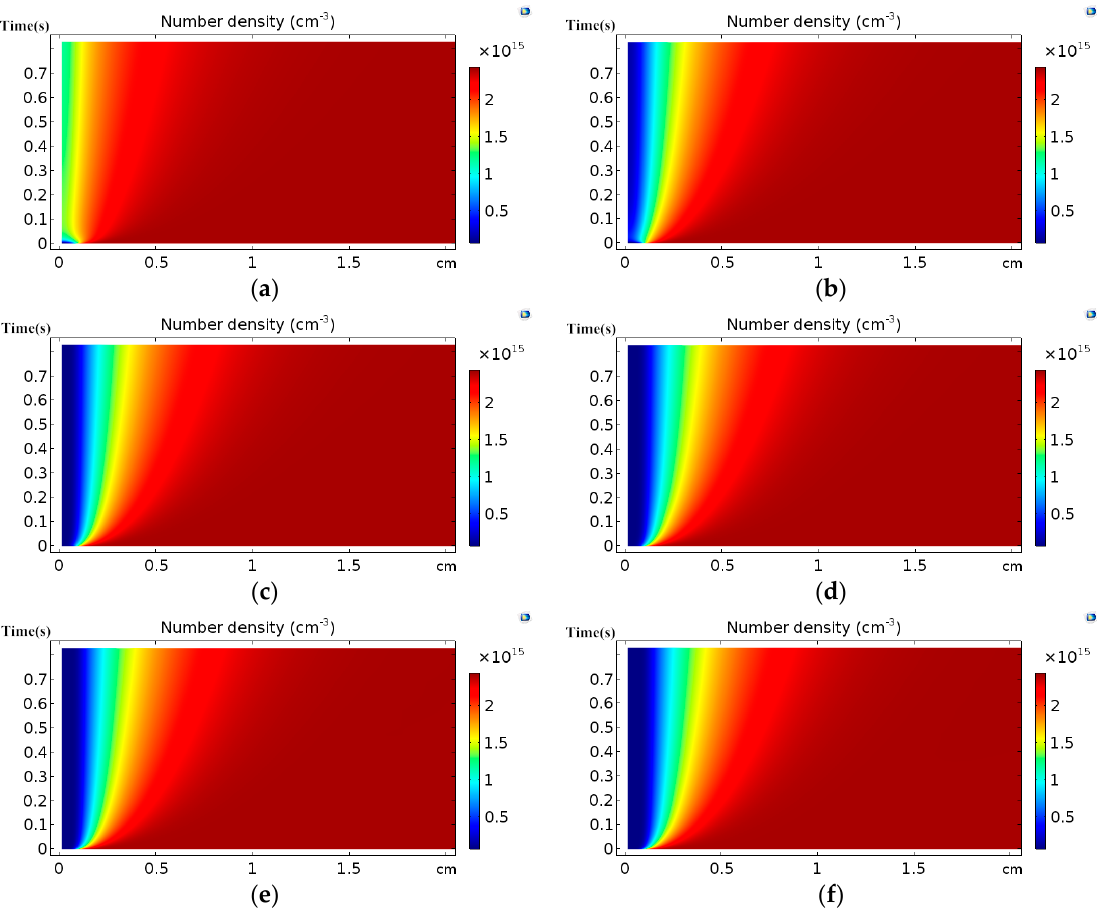
Figure 7. Effect of temporal and spatial evolution of the number density of NO: ( a ) − 25 KV; ( b ) − 30 KV; ( c ) − 35 KV; ( d ) − 40 KV; ( e ) − 45 KV; and ( f ) − 50 KV.